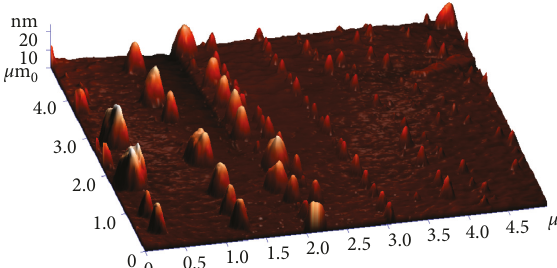
Figure 9: Three-dimensional image of the surface of an epitaxial film of a solid solution (GaAs) 1 − x (ZnSe) x , obtained by using an atomic force